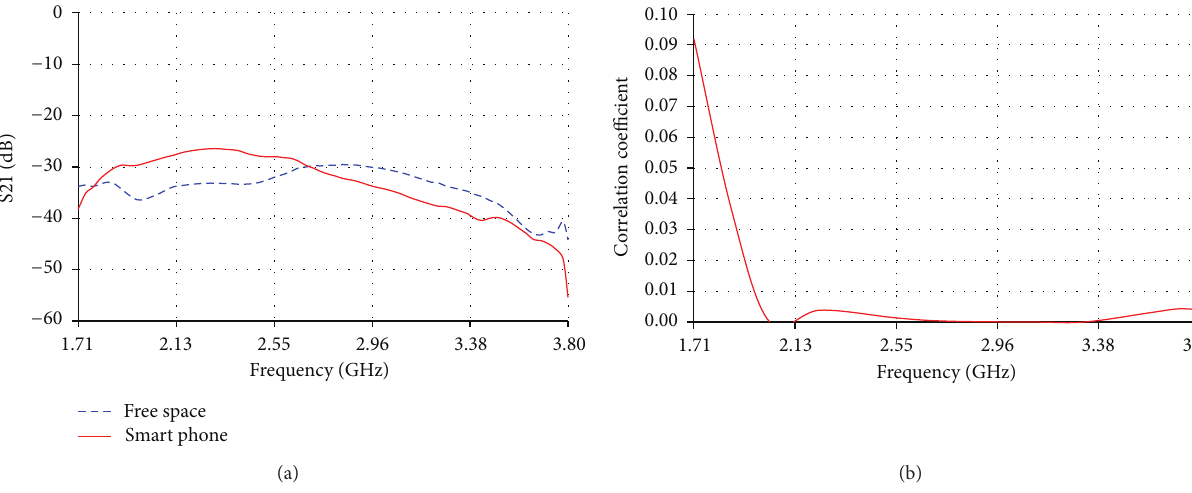
Figure 12: (a) Measured isolation (S21) and (b) correlation coefficient between primary and diversity MIMO high band antennas.